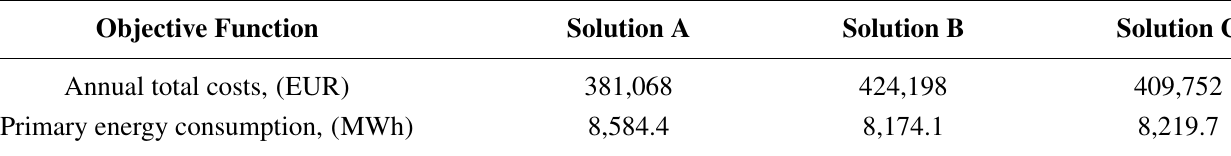
Table 4. Values of the objective functions for Solutions A, B and C.